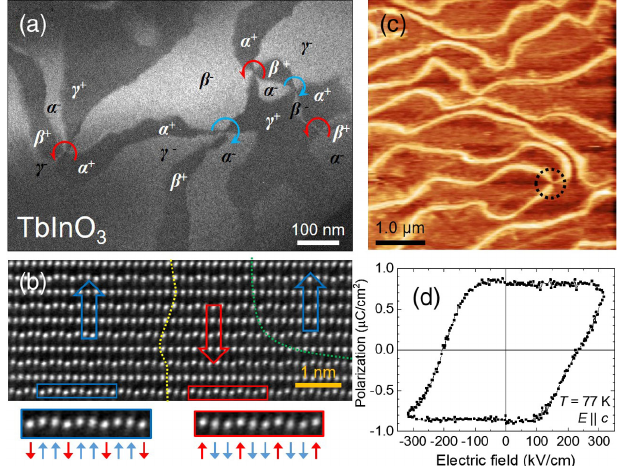
T.FIG. 2. (a) DF TEM images of polycrystalline TbInO 3 taken under the Friedel pair-breaking condition. The network of vortices with assigned phases ( α , β , γ , þ , − ) is depicted. (b) HAADF STEM image of polycrystalline TbInO 3 with two different polarized regions (blue- and red-boxed regions). The bottom row shows enlarged images and two different domain walls (yellow and green dotted lines). (c) Out-of-plane contrast PFM image of a single crystal within the ab plane. A topological vortex is located inside the dashed circle. (d) Electric polarization along the c axis as a function of the applied electric field of a single crystal measured at 77